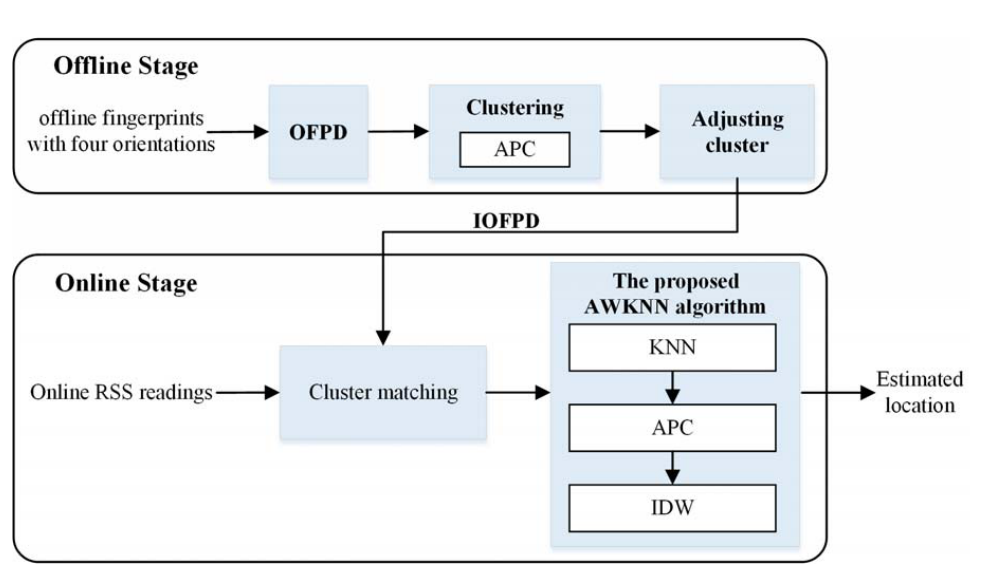
Figure 1. Flow chart of the proposed indoor localization method .